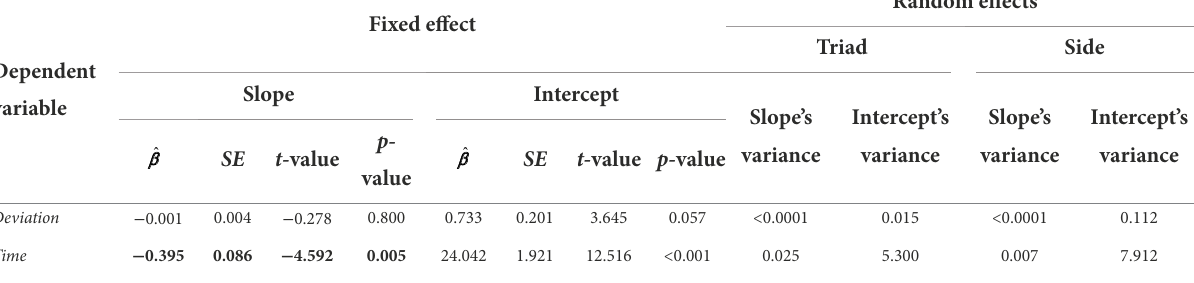
TABLE 2 Relationship between each task performance and trial considering the variabilities between triads and sides.